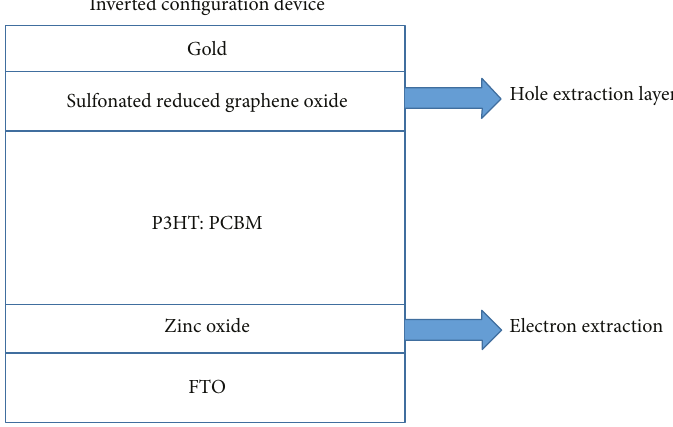
Figure 1: Schematic of the P3HT:PCBM